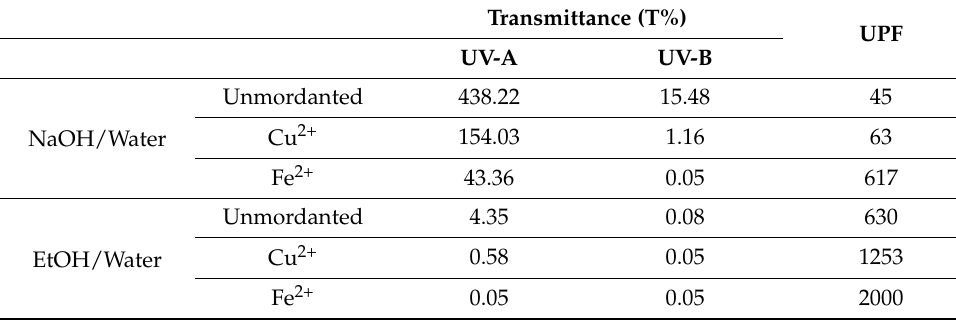
Table 9. UV protection of unmordanted and mordanted dyed